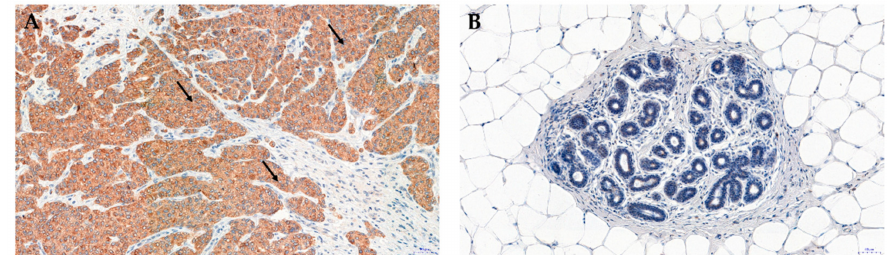
Figure 3. Expression of NUCB2/NESF-1 in invasive ductal breast carcinoma ( A ) and mastopathy ( B ) NUCB2/NESF-1 was located in the cytoplasm of breast cancer cells (black arrows) ( A ). Original magnification: × 200; for the immunohistochemical demonstration of NUCB2/NESF-1, Autostainer Link 48 (Dako, Glostrup, Denmark) with the visualization system of EnVisione FLEX, High pH (Dako) was used. NUCB2 was detected by incubation of deparaffinized sections with primary anti-nucleobindin 2 antibodies (rabbit polyclonal antibody, Novus Biologicals, Littleton, CO, USA). Suzuki et al. were the first to identify NUCB2/NESF-1 as an estrogen receptor- associated protein. They found NUCB2/NESF-1 to be a gene associated with the